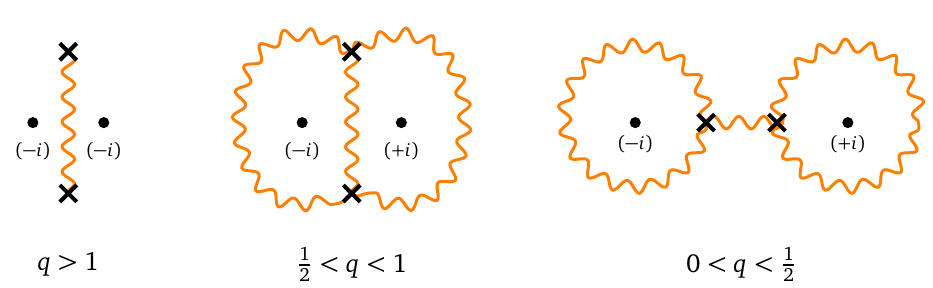
Figure 1.1: Depending on the kinematic parameter q = ε k 0 / s , the solutions of the scattering equations localize along different kinds of